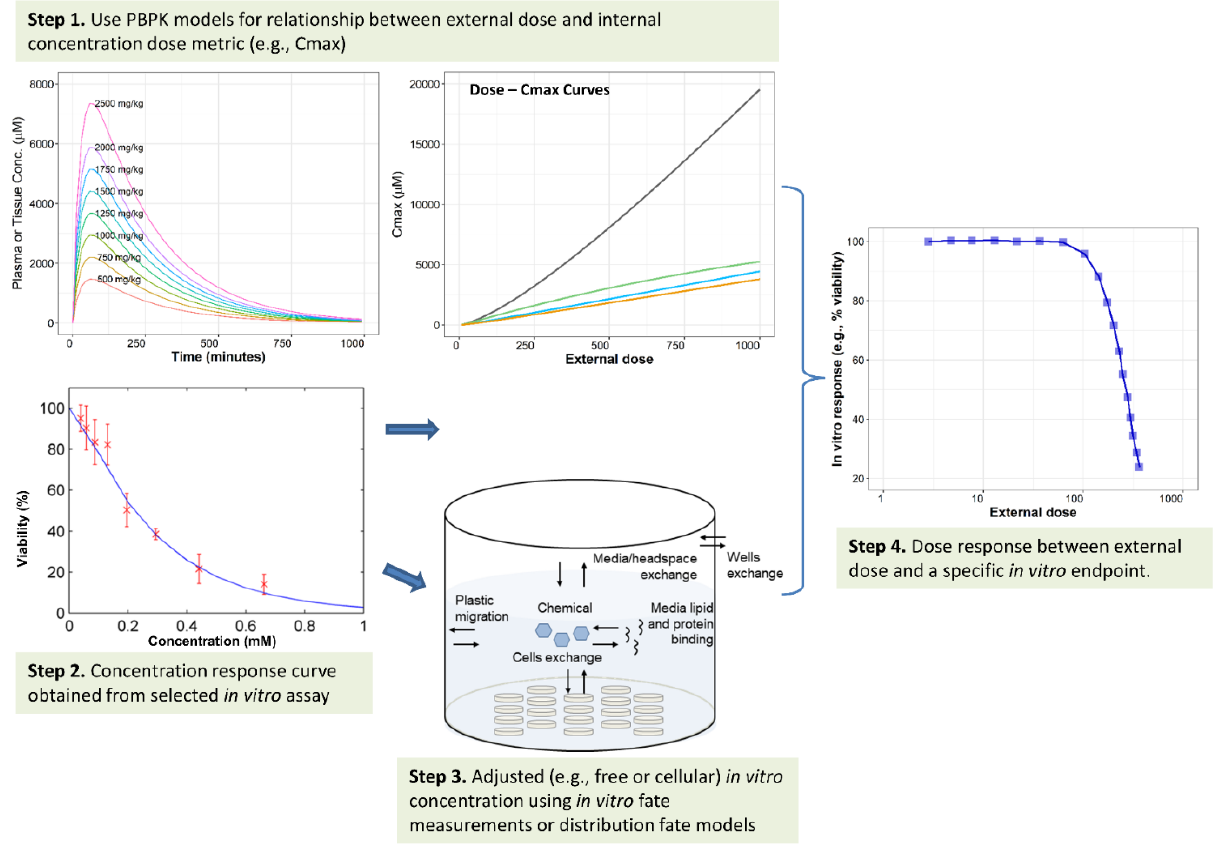
Figure 3. Consideration of in vitro kinetics in IVIVE of dosimetry. Step 1. Execute the PBPK model at the time point of interest at multiple doses to obtain chemical distribution in plasma and tissue compartment. Then, use the dose – response curve to determine the relationship between the external dose and Cmax or other internal dose metric (e.g., AUC) in plasma or selected tissue (e.g., liver). Step 2. Concentration – response curve obtained from selected in vitro assay. Nominal concentration is used for plotting. Step 3. Using appropriate in vitro kinetic models, adjust the in vitro nominal concentra- tion in the testing well to free medium or cellular concentration. Step 4. Combine the external dose – Cmax curve form Step 1 and in vitro concentration – response curve (Step 2 or Step 3) to obtain a relationship between external dose and in vitro endpoint. Adapted from Paini, et al. [39].